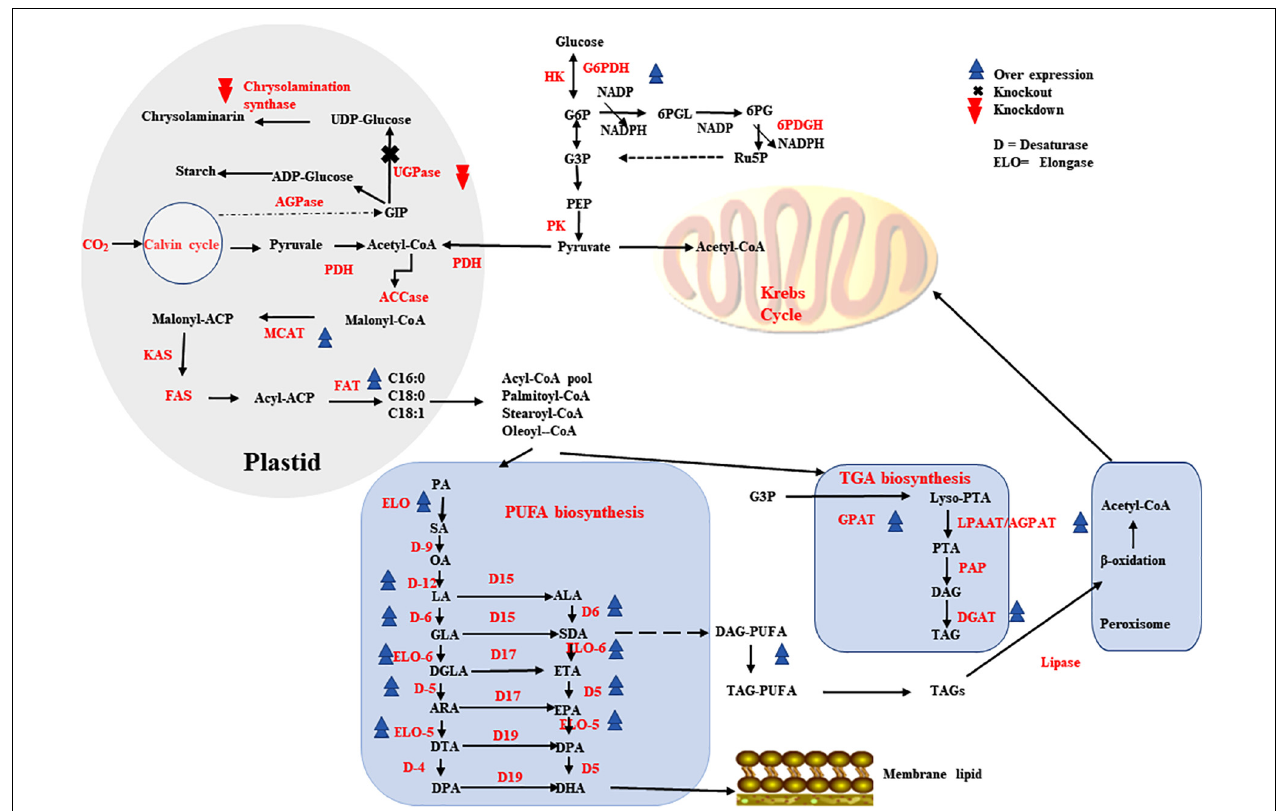
FIGURE 3 | Metabolic engineering strategies that contributes higher production of PUFAs in higher